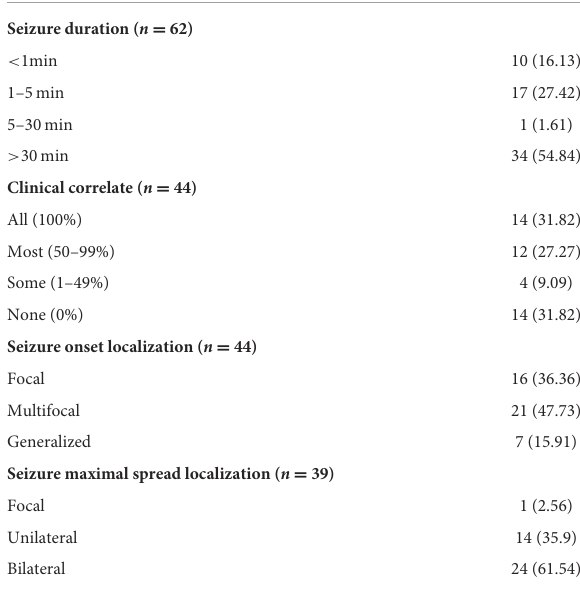
TABLE 3 Electrographic seizure characteristics of 88